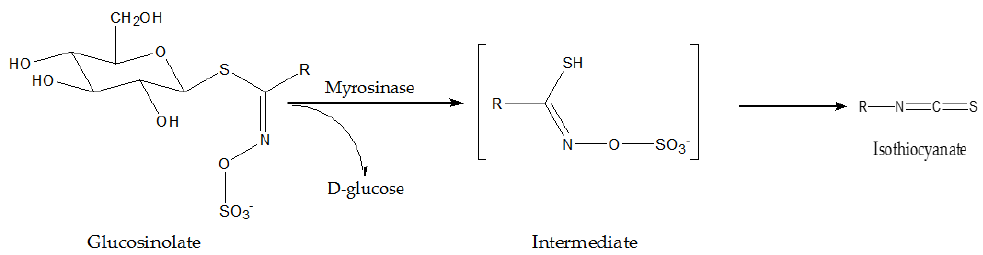
Figure 1. The general structure of glucosinolates and their enzymatic conversion to isothiocyanates by myrosinase.